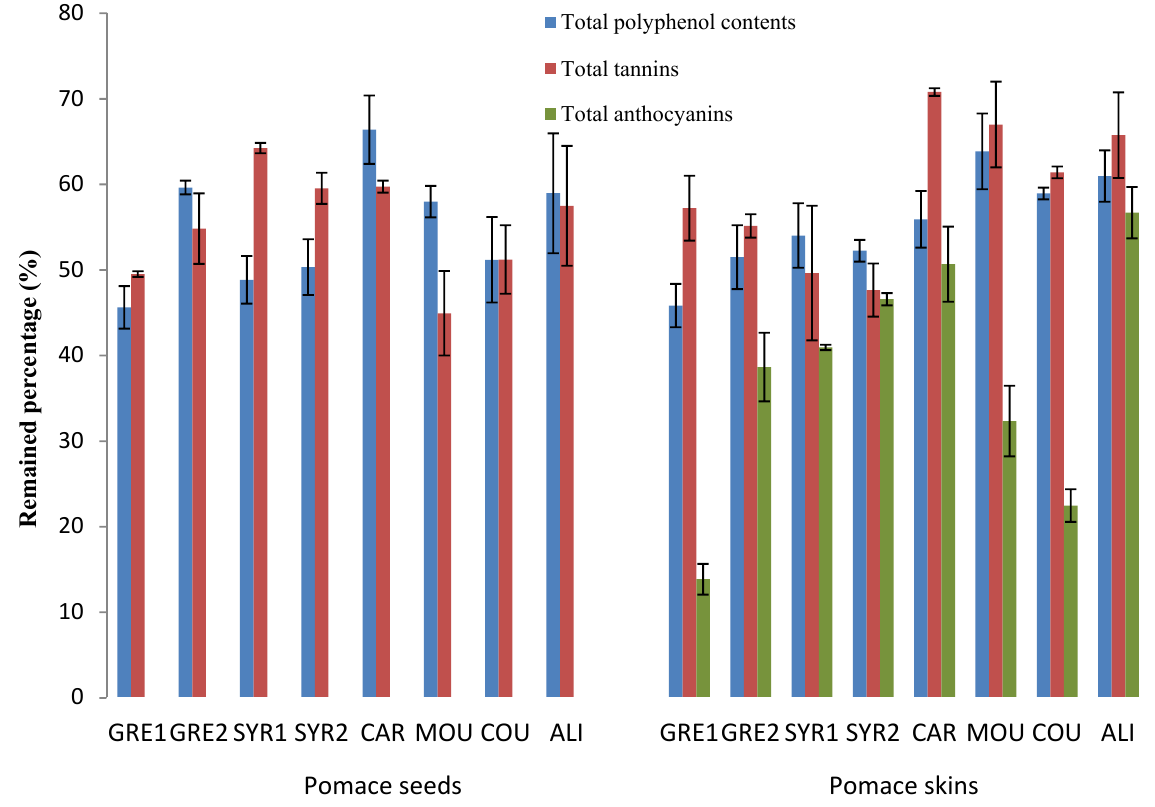
Figure 1. Residual phenolics (total polyphenol contents, total tannins and total anthocyanins) in 2010 grape seed and skin pomace